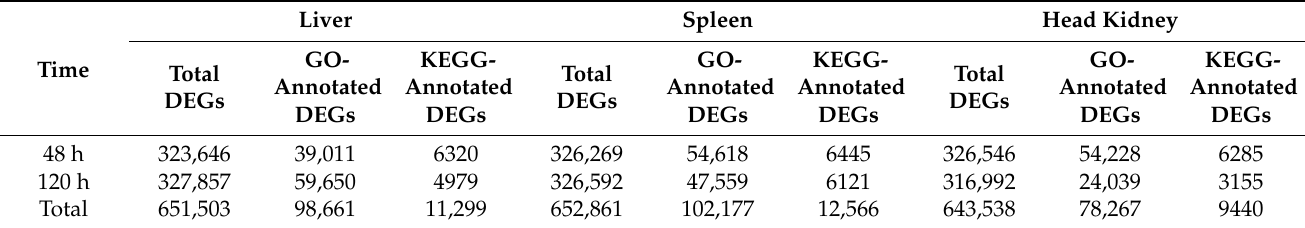
Table 3. Annotated DEGs in gene ontology and KEGG